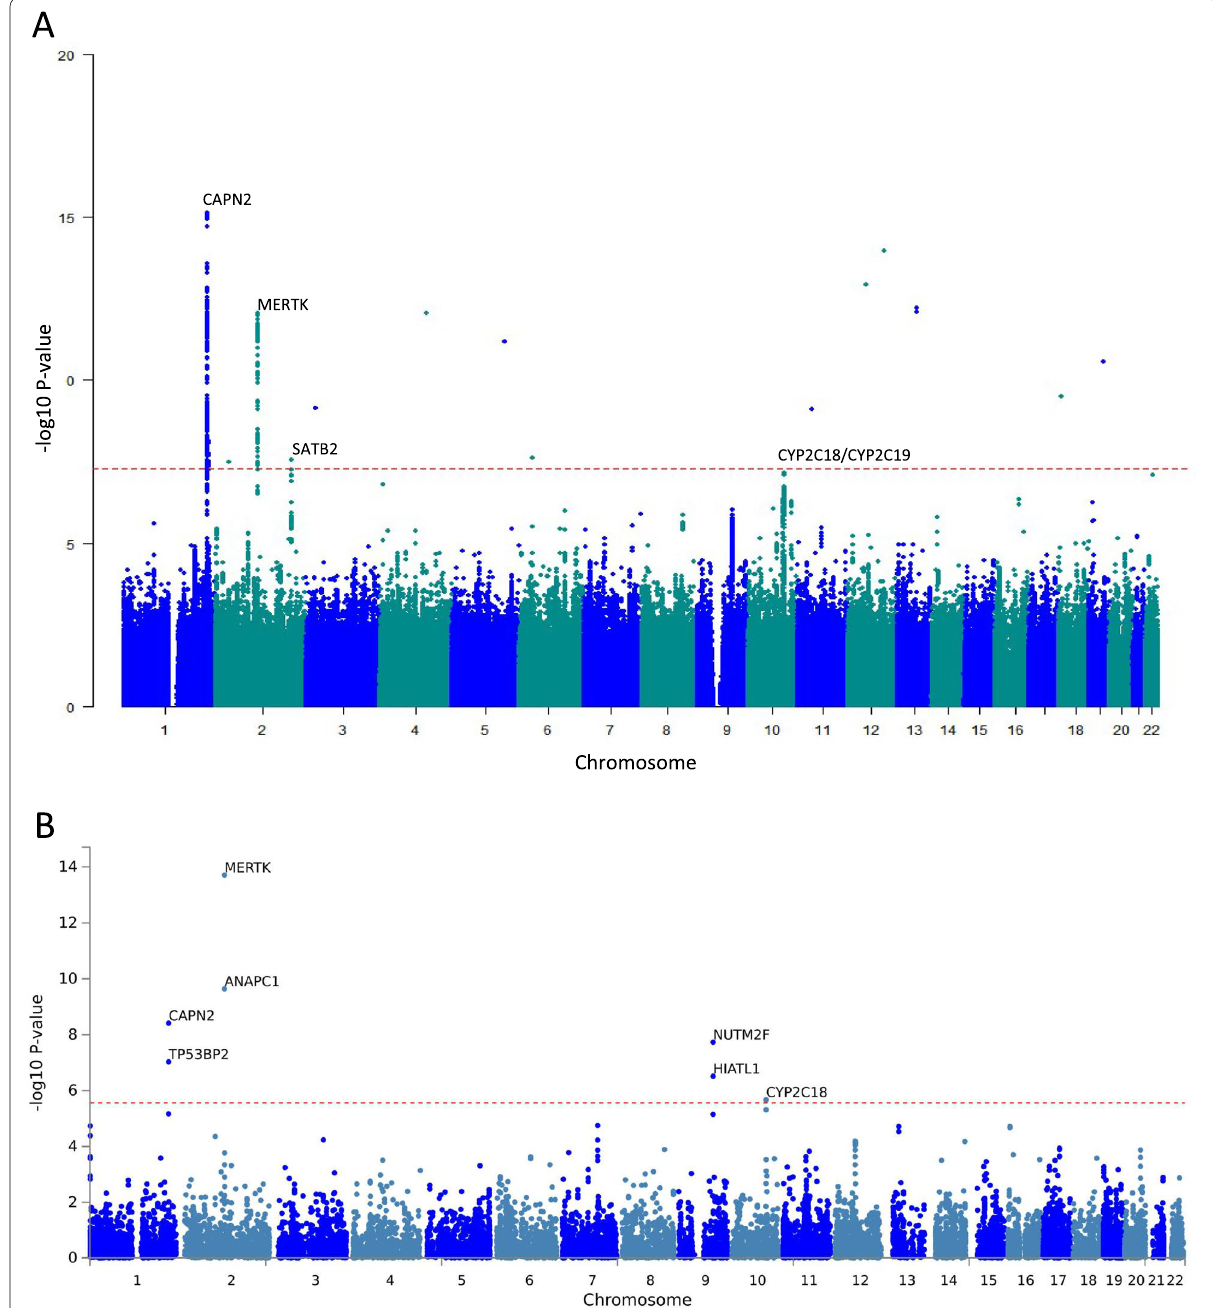
Fig. 1 Manhattan plots for the GWAS and gene‑based analysis. A Manhattan plot for the associations of SNPs with cluster headache. The horizontal axis shows the chromosomal position, and the vertical axis shows the significance of tested markers. The threshold for genome wide significance ( p < 5 10 –8 ) is indicated by a red dash line. B Manhattan plot of the gene‑based test as computed by Multimarker Analysis of GenoMic Annotation × (MAGMA). The input SNPs were mapped to 18,460 protein coding genes. The red dash line indicates the genome wide significance defined at p 0.05/18,460 2.709 10 = = ×